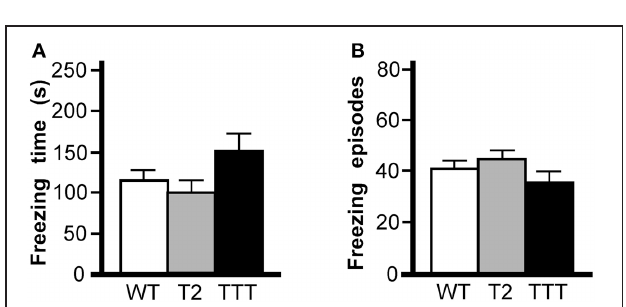
FIGURE 4 | Contextual fear conditioning in mice lacking Trek channels. Wild-type (WT, white), Trek2 − / − (T2, gray), and Trek1/2 / Traak − / − (TTT, black) mice were evaluated in 5min (300s) contextual fear conditioning test ( n = 9–14 per group). (A) Time spent freezing; no genotype-dependent differences were observed with respect to time spent freezing [ F ( 2 , 34 ) = 2 . 4, P = 0 . 11]. (B) Freezing episodes; no genotype-dependent differences were observed with respect to number of freezing episodes [ F ( 2 , 34 ) = 1 . 4, P = 0 . 25].